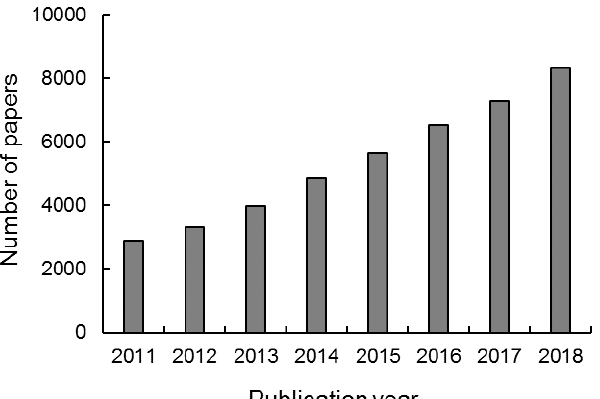
Figure 1. Number of papers published annually on nanomaterials (searched in Web of Science using “nanomaterials”, October 09, 2019).